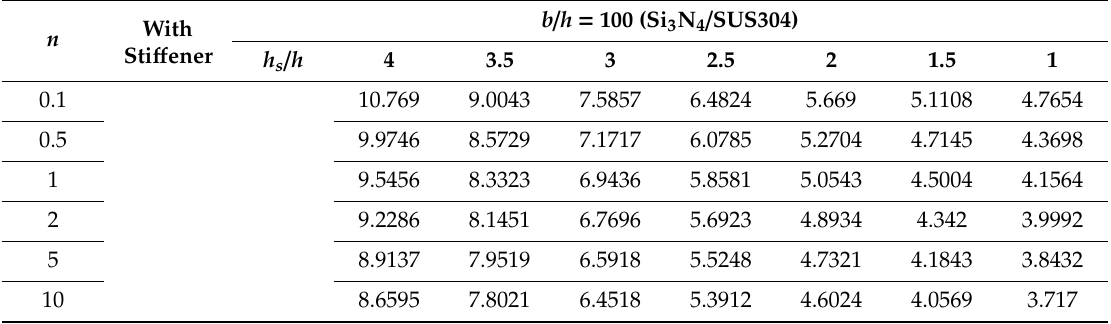
Table 4. Buckling coe ffi cient of FGM plate with and without a central sti ff ener (Si 3 N 4 / SUS304, b / h =